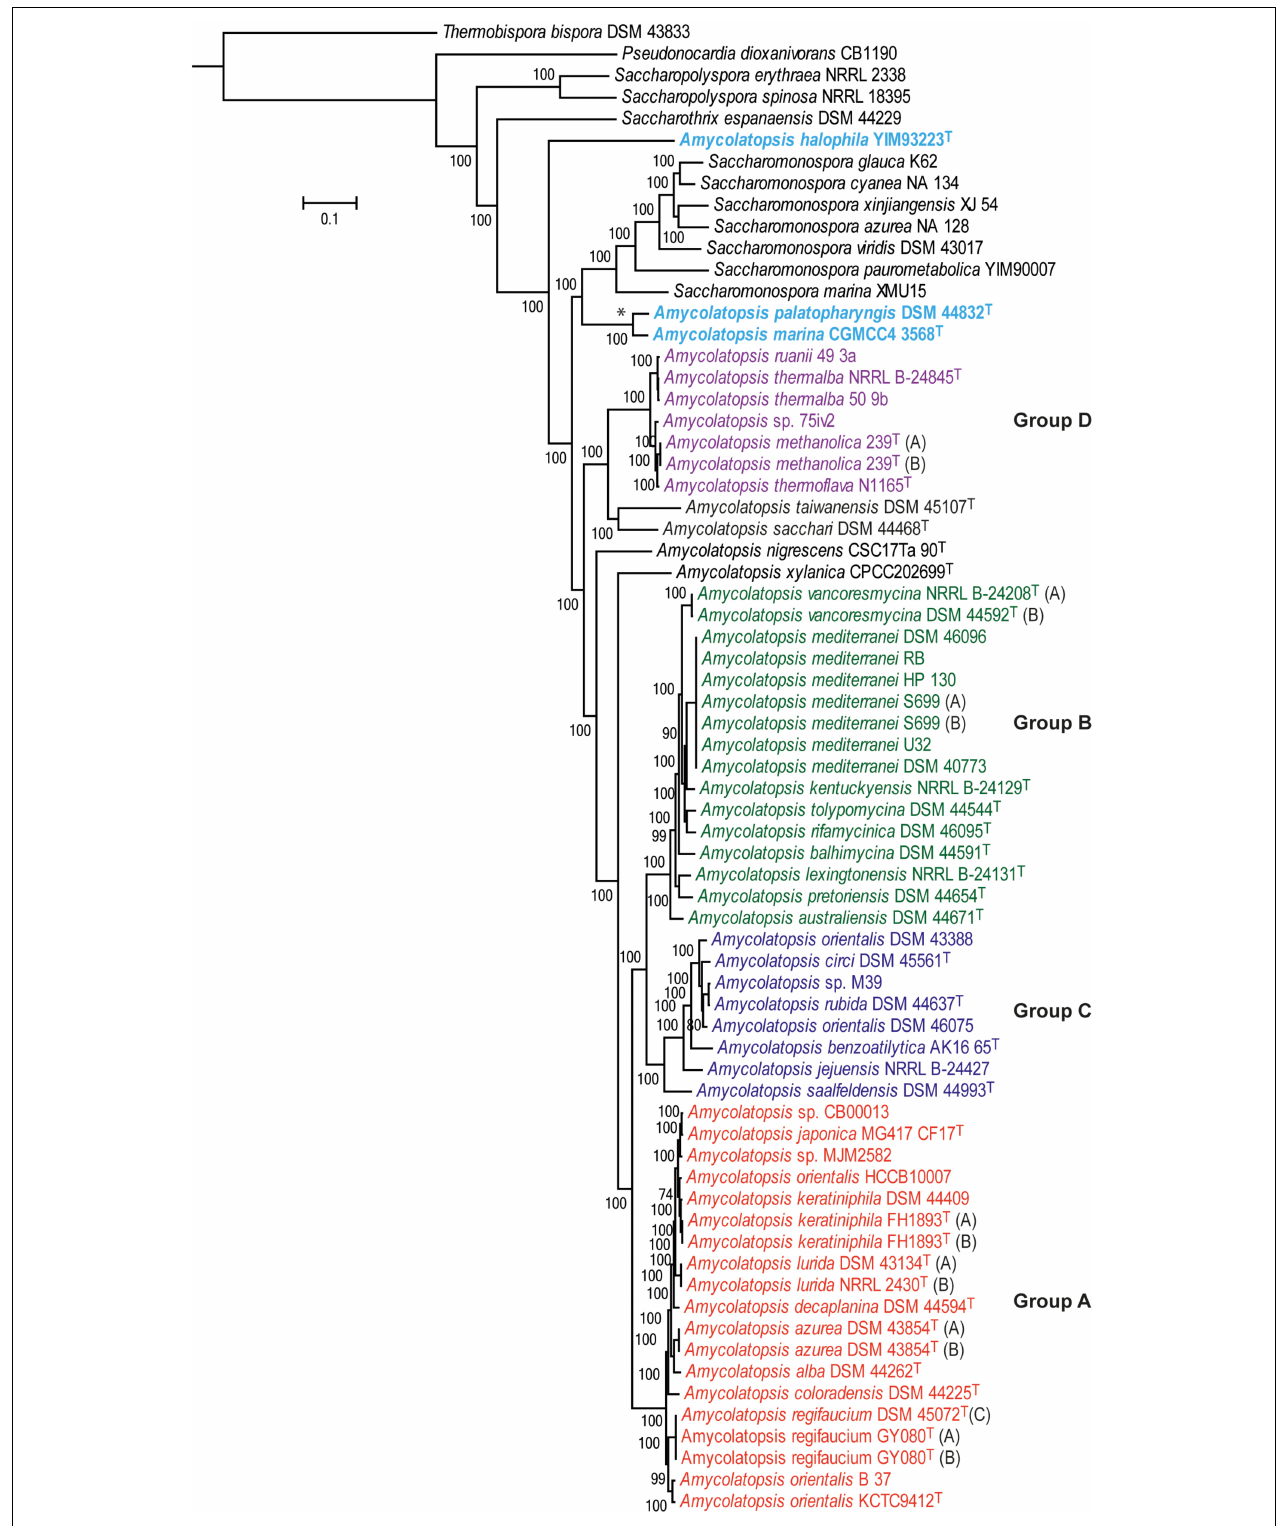
FIGURE 1 | A maximum-likelihood tree derived from concatenated core protein sequences. The scale bar represents amino acid substitutions per site. Amycolatopsis groups are labeled and shown in different colors. The clade with the two Amycolatopsis strains that are more close to Saccharomonospora strains is labeled with a star ( ∗ )